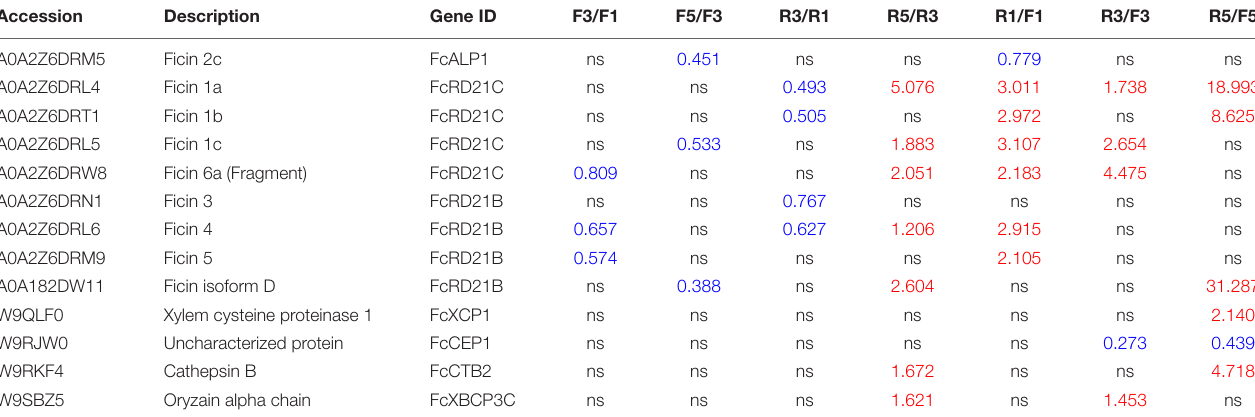
TABLE 3 | Papain-like cysteine proteases (PLCPs) identified in fig fruit soluble proteome and comparison of their abundance in the inflorescence and receptacle during fruit development. Accession